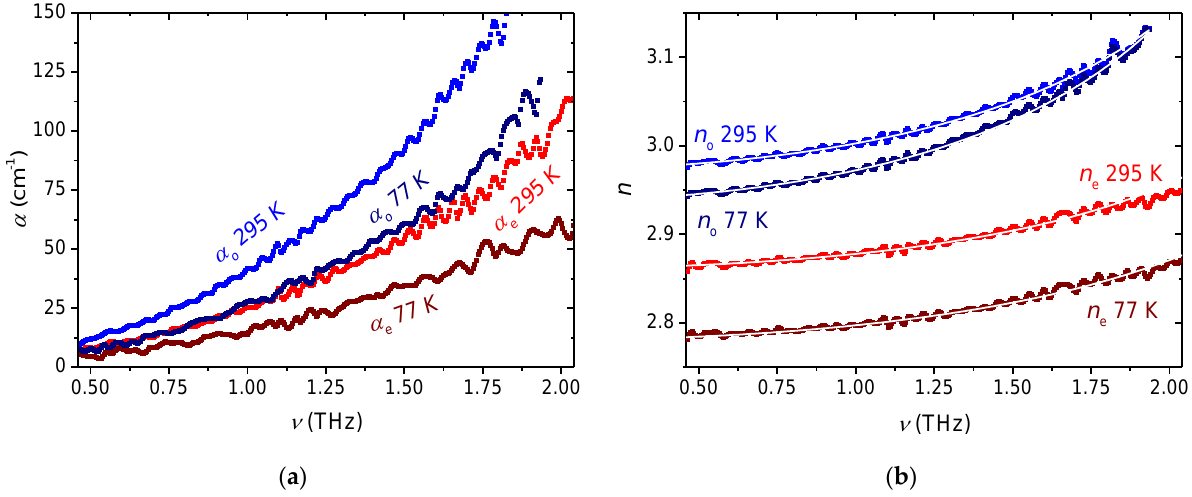
Figure 2. Optical properties of the LB4 crystal in the THz range: ( a ) Absorption coefficient; ( b ) dispersion of the refractive index. White lines on top of the experimental data are plotted according to the Sellmeier equation as a visual guide.